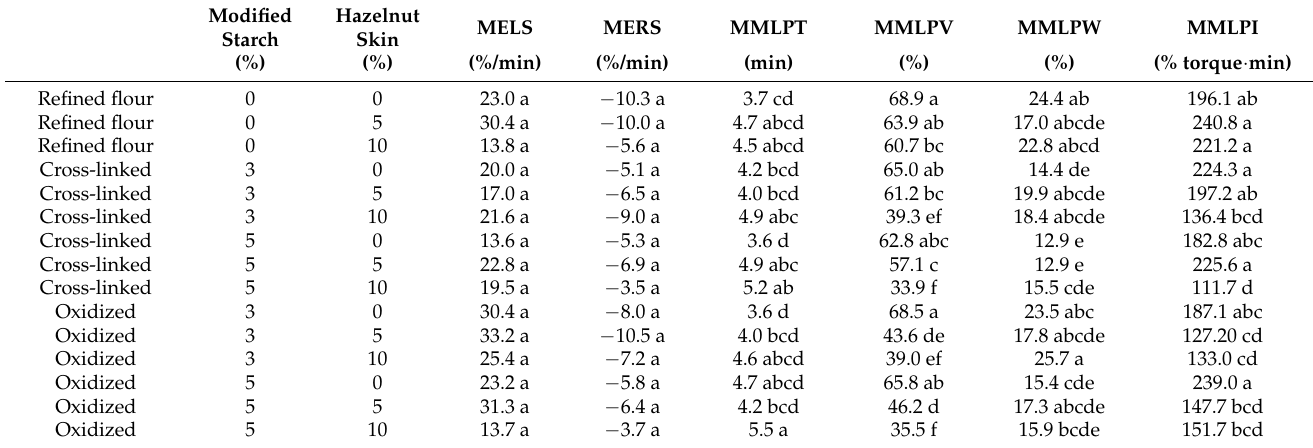
Table 2. Mixograph results of dough prepared with hazelnut skin and modified